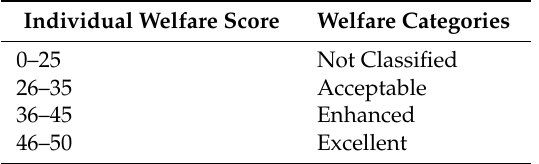
Table 2. The classification of the individual welfare scores in qualitative categories of